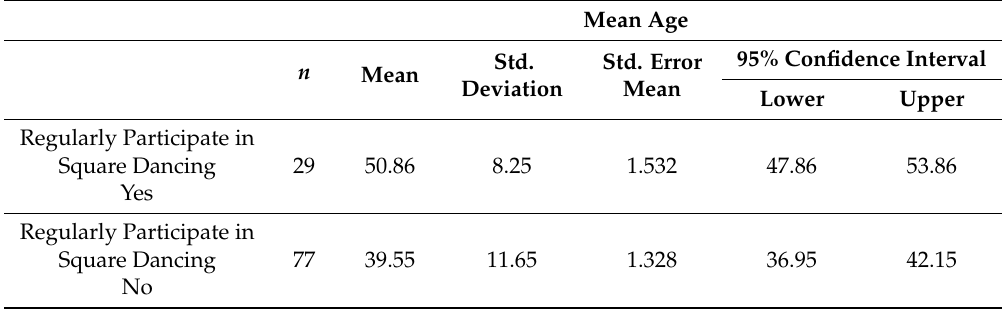
Pr(|T| > |t|) = 0.0000 t =